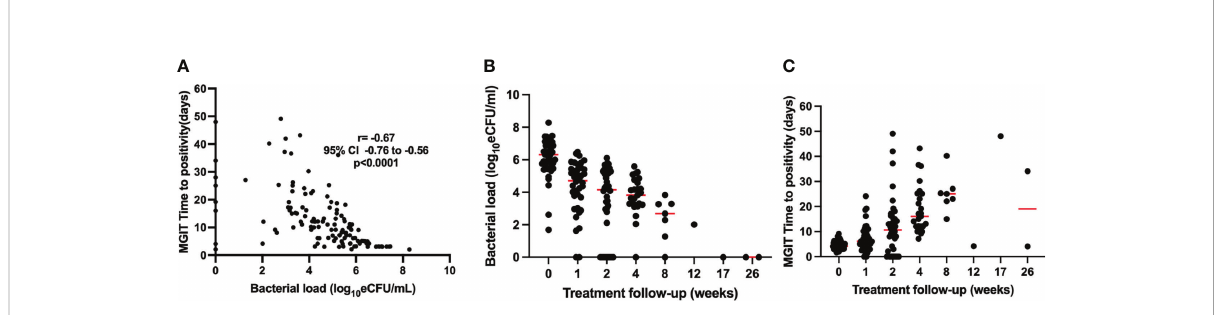
FIGURE 2 Correlation of bacterial load measured by TB-MBLA and MGIT TTP over treatment follow-up (A) . TB-MBLA had a lower variation from the median (B) than MGIT TTP for which variation from median increased with treatment and many data points were censured due to contamination (C)